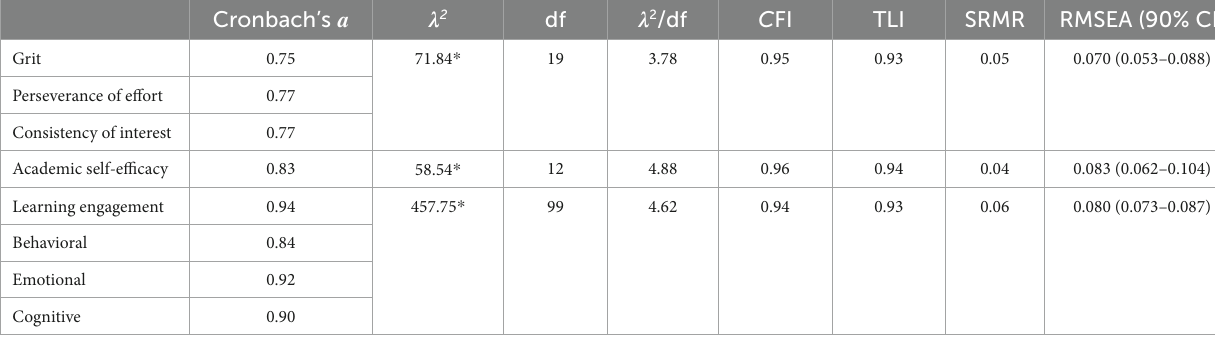
TABLE 1 Summary of reliability and construct validity of the